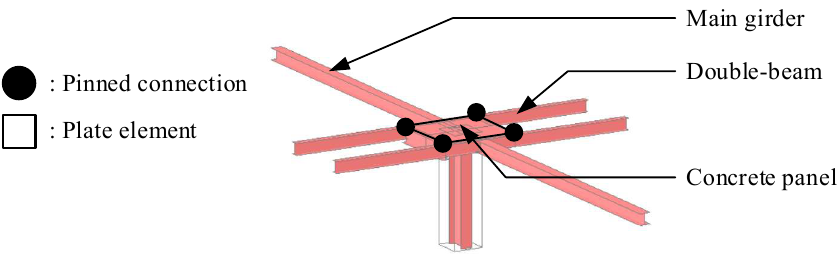
Figure 6. Modeling of connections using plate elements with beam-end release conditions in the steel double-beam floor system reinforced with the concrete panel (DBO system).